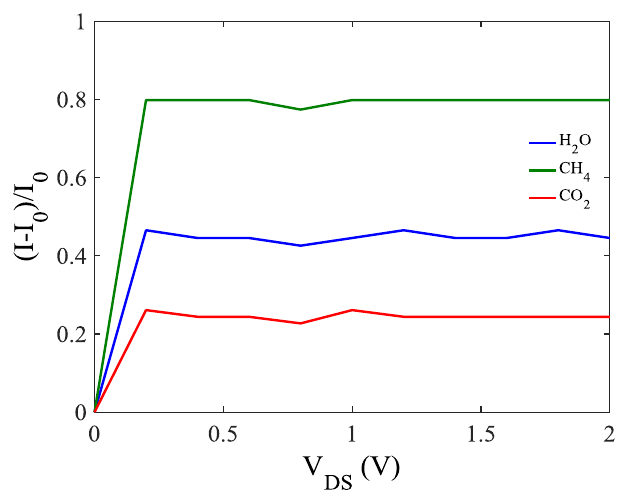
Figure 7. The response of ZCNT-FET based gas sensor toward adsorbed gas molecules.